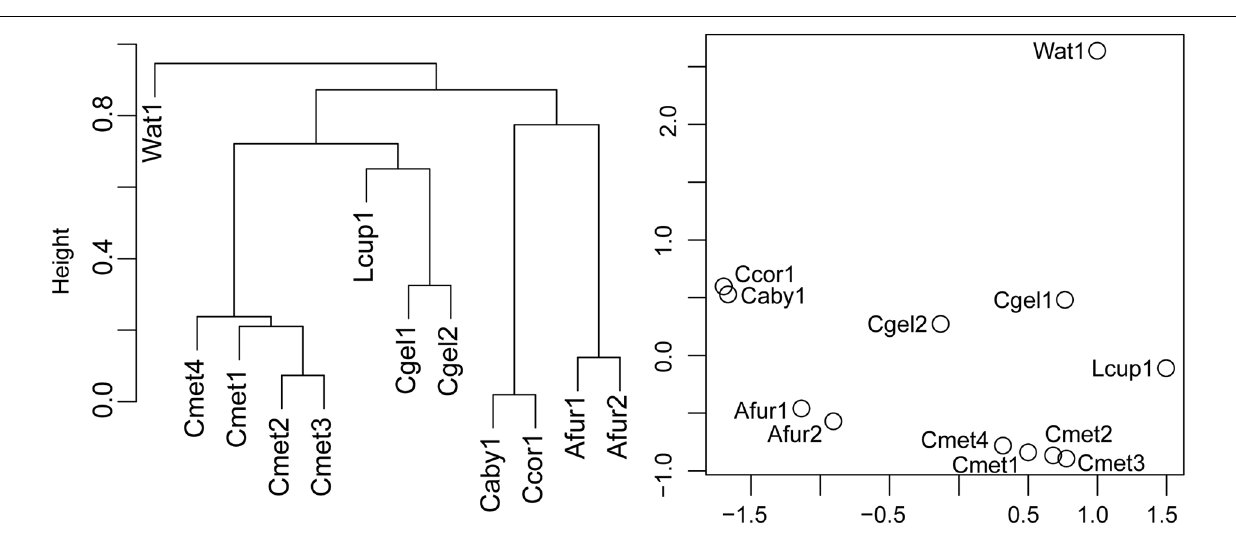
FIGURE 8 | Cluster analysis and NMDS plot of normalized Bray–Curtis pairwise distances for 97% OTUs from specimens in the